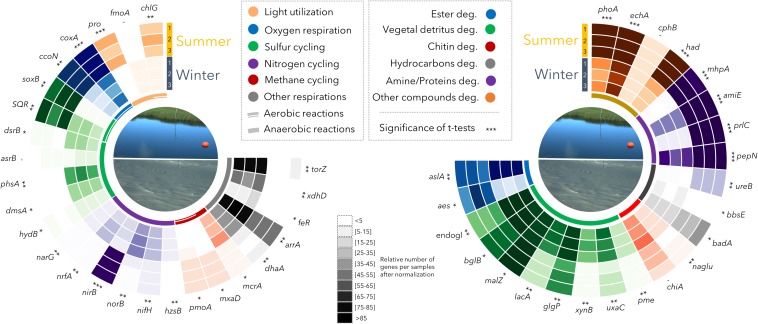
Relative proportion of metabolic genes identified in Summer (S1, S2, S3) and Winter (W1, W2, W3) samples. The relative abundance of selected genes was represented by a 10-interval shading, with darker shades indicating higher abundance. Significance of t-tests: -, not-significant; *p < 0.05; ∗∗p < 0.01; ∗∗∗p < 0.0005. chlG: chlorophyll synthase; fmoA: bacteriochlorophyll A protein; pro: proteorhodopsin; coxA: cytochrome c oxidase subunit 1; ccoN: cytochrome c oxidase cbb3-type; soxB: sulfur-oxidizing protein; sqr: sulfide_quinone oxidoreductase; dsrB: sulfite reductase; asrB: anaerobic sulfite reductase; phsA: thiosulfate reductase/polysulfide reductase; dmsA: anaerobic dimethyl sulfoxide reductase; hydB: sulfhydrogenase; narG: nitrate reductase: nrfA: nitrite reductase (cytochrome c-552); nirB: nitrite reductase; norB: nitric oxide reductase; nifH: nitrogenase, hzsB: hydrazine hydrolase (Anammox); pmoA: methane monooxygenase; mxaD: methanol dehydrogenase; mcrA: methyl coenzyme M reductase; dhaA: haloalkane dehalogenase; arrA: arsenate respiratory reductase; feR: ferric-chelate reductase; xdhD: selenate reductase; torZ: trimethylamine-N-oxide reductase; aslA: arylsulfatase; aes: acetyl esterase; endogl.: endoglucanase; bglB: beta-glucosidase; malZ: alpha-glucosidase; lacA: beta-galactosidase; glgP: starch phosphorylase; xynB: xylanase‘; uxaC: glucuronate isomerase; pme: pectinesterase; chiA: chitinase; naglu: alpha-N-acetylglucosaminidase; badA: benzoate-CoA ligase; bbsE: benzylsuccinate CoA-transferase; ureB: urease; pepN: aminopeptidase; prlC: oligopeptidase; amiE: amidase; mhpA: (hydroxy-phenyl)propionate hydroxylase; had: haloacid dehalogenase; cphB: cyanophycinase; echA: enoyl-CoA hydratase; phoA: alkaline phosphatase. Soluble methane monooxygenase gene (mmoX) was only detected at very low levels in sample S1.